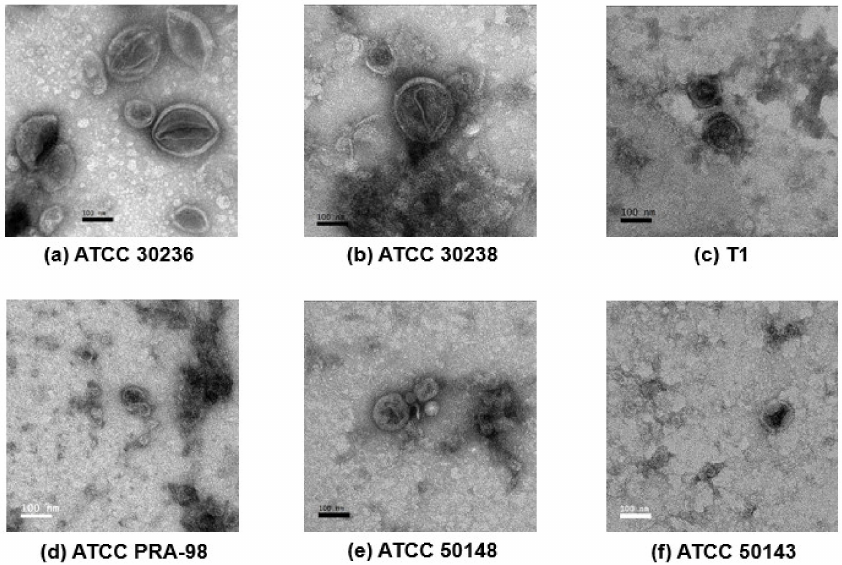
Figure 2. Transmission electron microscopy (TEM) of the small extracellular vesicles (sEVs) derived from T. vaginalis isolates; ( a ) ATCC 30236, ( b ) ATCC 30238, ( c ) T1, ( d ) ATCC PRA-98, ( e ) ATCC 50148 and ( f ) ATCC 50143. The morphology of purified sEVs of the six T. vaginalis isolates after ultracentrifugation were identified using negative staining with 1% uranyl acetate and observed under TEM. (Original magnification, 80,000 × ; scale bar = 100